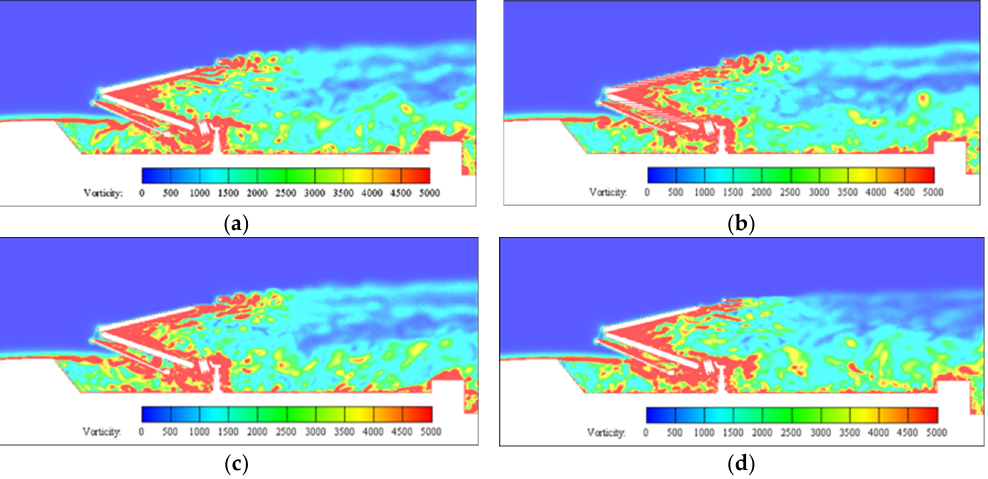
Figure 5. The vorticity amplitude distribution on the longitudinal symmetry surface. ( a ) Original model. ( b ) Opened model. ( c ) Slotted model. ( d ) Airfoil model.